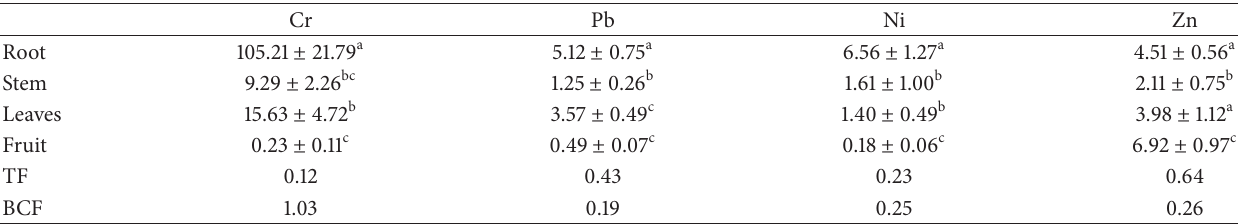
Table 1: The accumulation of heavy metals (mg/kg) in maize roots, stems, leaves, and fruits, the maize TF and BCF values, and the ANOVA results for the heavy metals concentrations at site